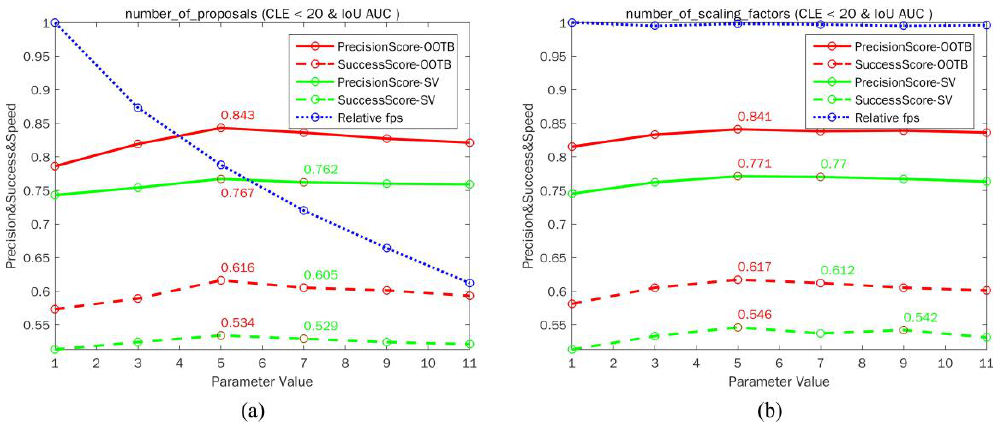
Figure 7. The tracking accuracy and speed under different settings of parameters: ( a ) the number of proposals N ( b ) the number of scaling factors n . In the legend, precision and success plots on OOTB dataset and its subset (scale variation) using OPE are shown, and relative fps is collected on the OOTB dataset. The values of highest and the second highest accuracies are shown in red and green